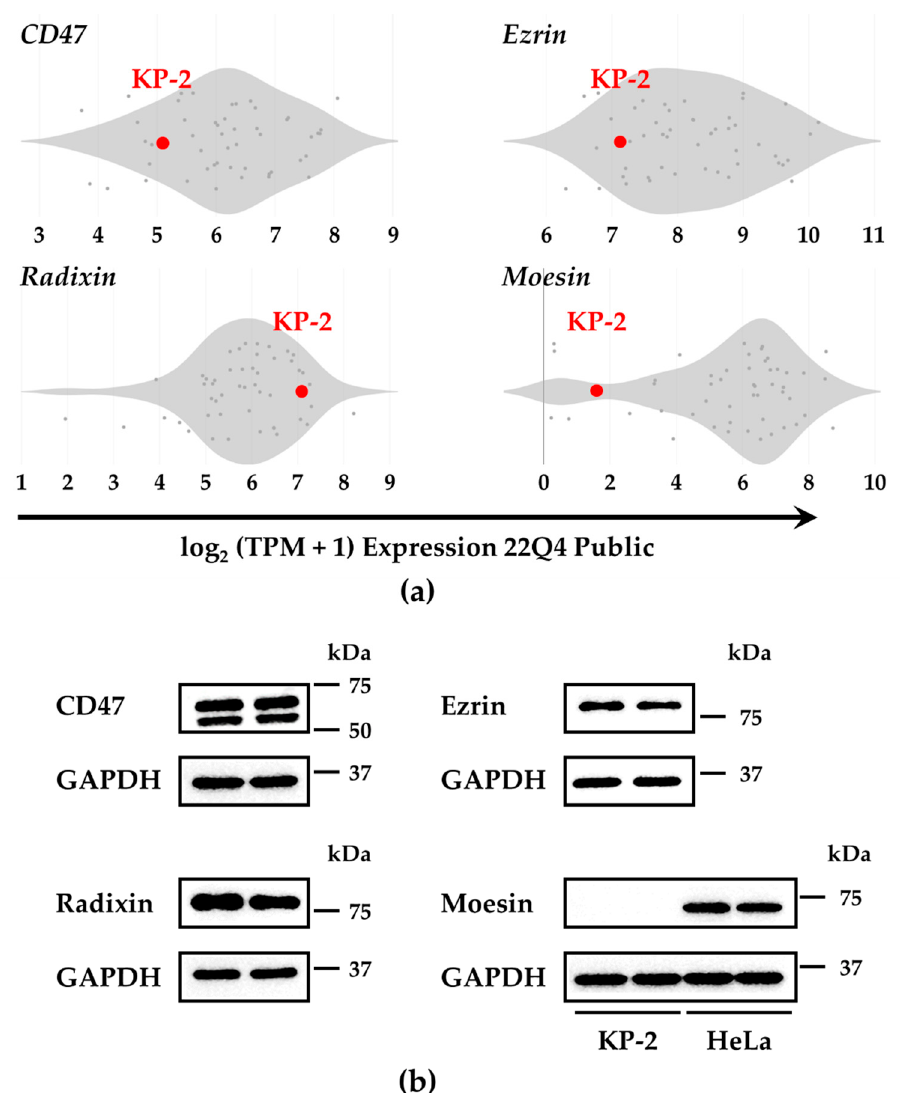
Figure 1. Expression pattern of CD47, ezrin, radixin, and moesin (ERM) in KP-2 cells. ( a ) Violin plots representing the median mRNA expression as log 2 [transcripts per million (TPM) + 1] of each gene in 50 human pancreatic adenocarcinoma cell lines based on the datasets from the Cancer Dependency Map (DepMap), Broad (2022): DepMap 22Q4 Public. ( b ) Representative immunoblots for each protein in the whole-cell lysates extracted from KP-2 cells. HeLa: a positive control cell line in which moesin was endogenously expressed. GAPDH: glyceraldehyde-3-phosphate dehydrogenase, kDa: Molecular weights.